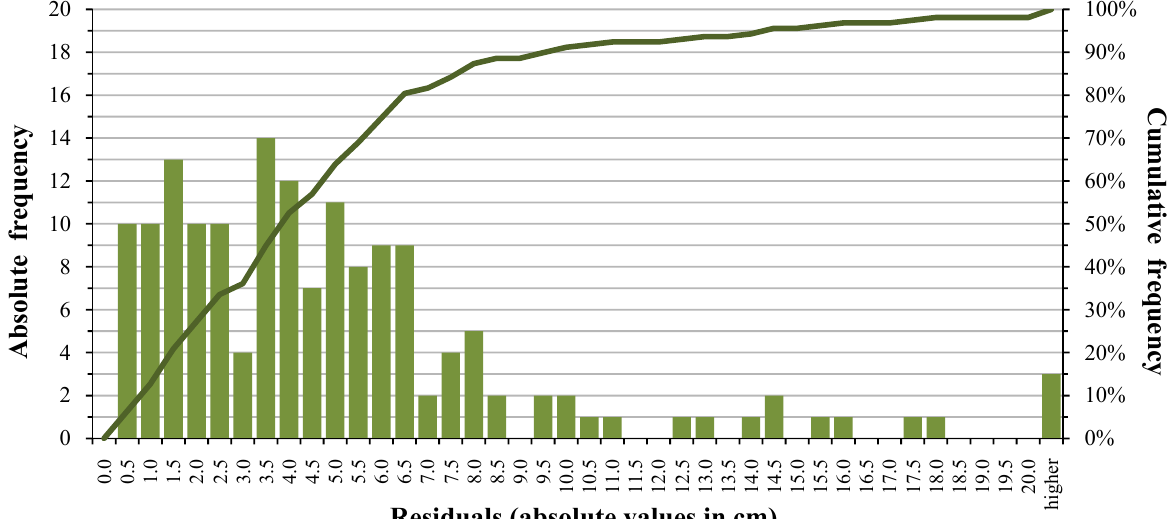
Figure 9. Histogram and cumulative frequency of residuals in absolute value for the field distance measurement trial.